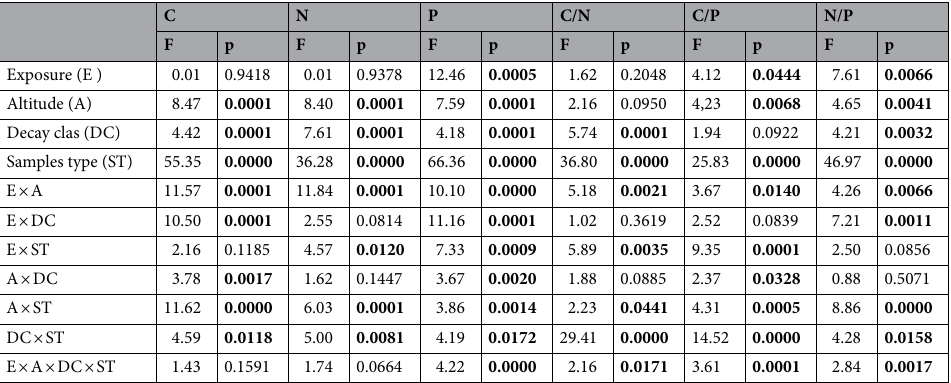
Table 1. GLM analysis for C, N, P content and C/N/P stoichiometry. Significance effect ( p < 0.05) are show in